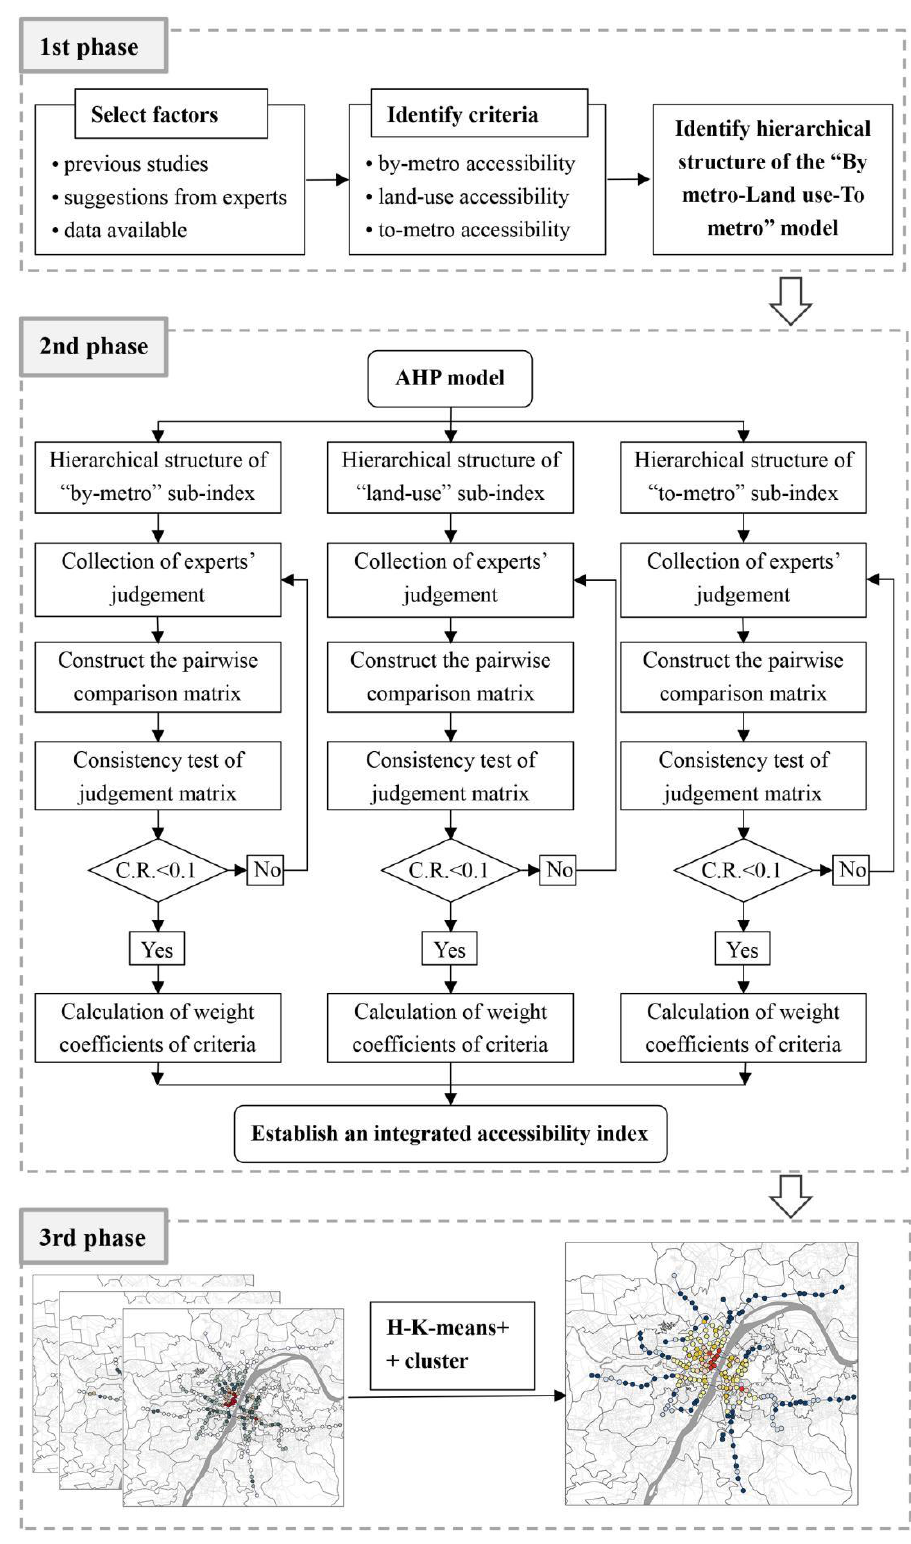
Figure 1. Flow chart of the present study.